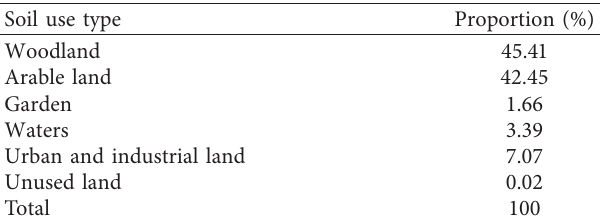
Table 1: Land-use types in the Biliu River Basin. Soil use